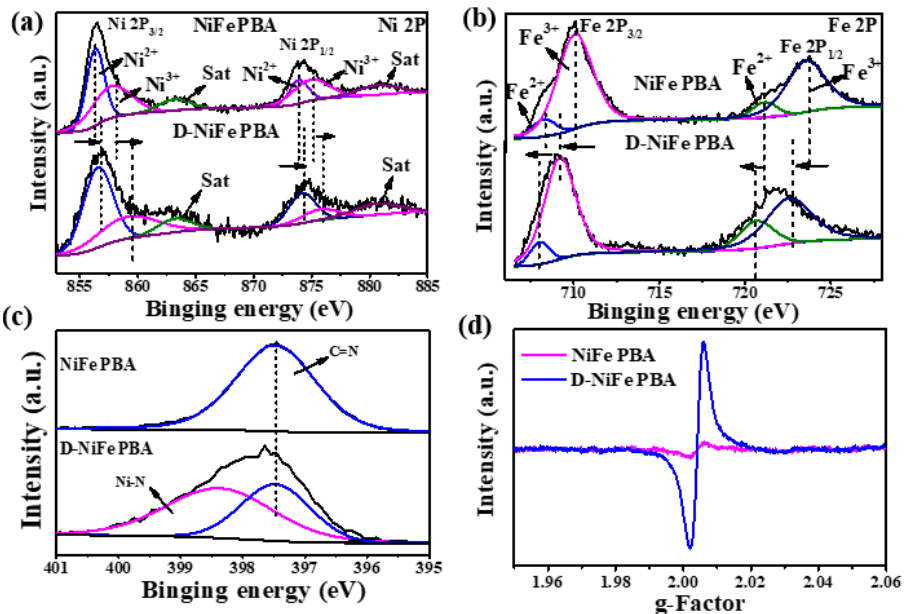
Figure 4. ( a ) Ni 2p spectra, ( b ) Fe 2p XPS spectra, ( c ) N 1s spectra, and ( d ) EPR spectra of NiFe PBA and D-NiFe PBA.